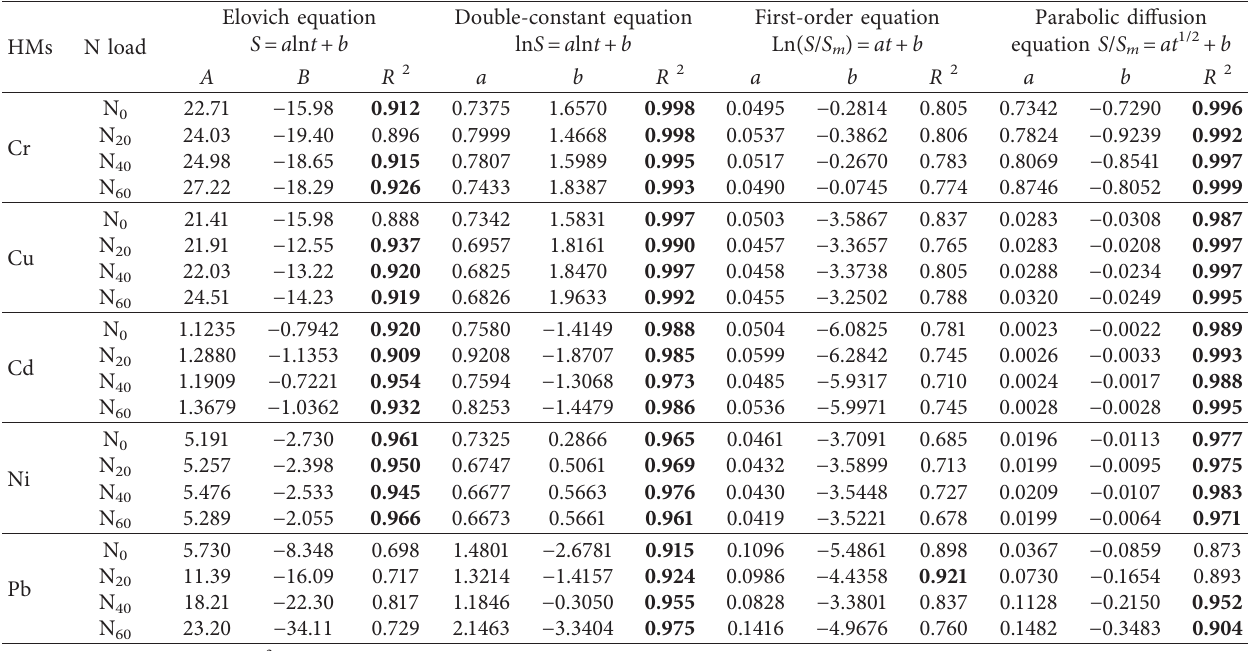
Table 4: Fitting parameters of each kinetic model for HMs in the WFLZ soil in the TGR area under N deposition. HMs N load